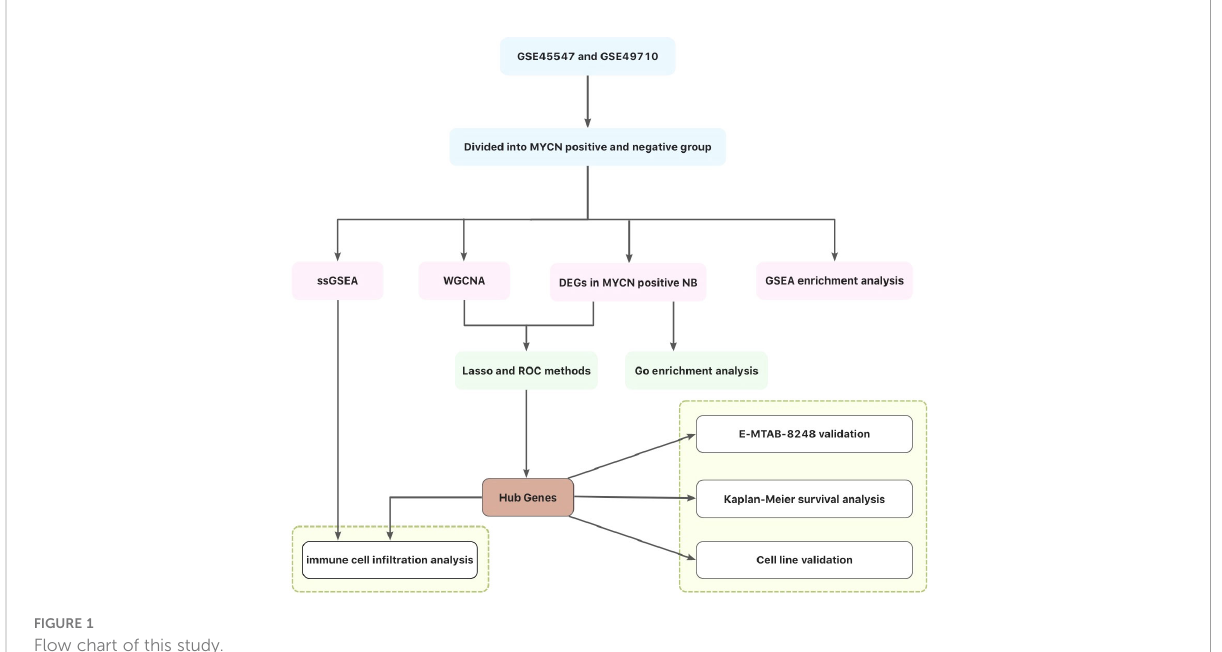
FIGURE 1 Flow chart of this